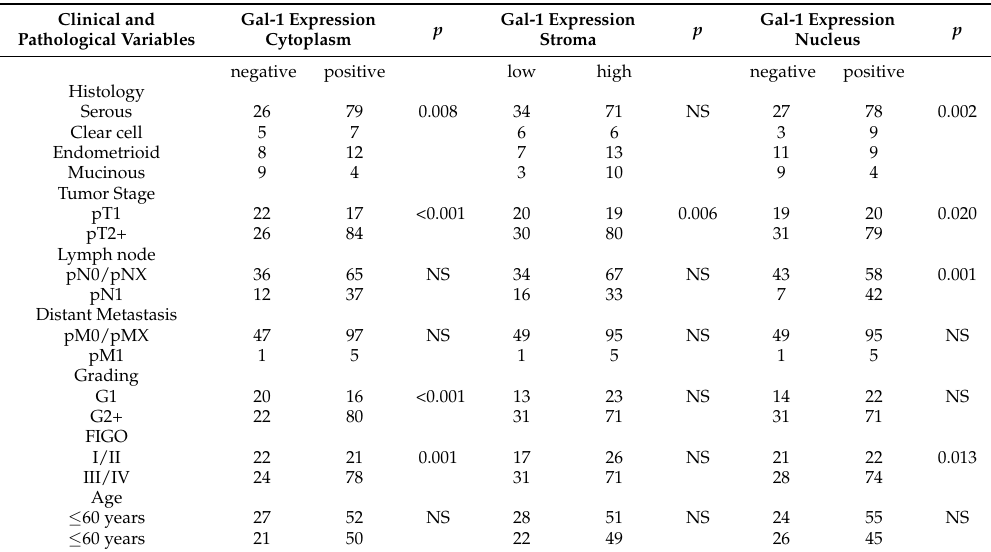
Figure 1. Detection of Galectins by immunohistochemistry. Representative photomicrographs are shown. Galectin (Gal)-1 was present in the cytoplasm and the nuclei of ovarian cancer cells ( A ) as well as the peritumoral stroma ( B ); Gal-3 staining was observed in the nuclei, cytoplasm ( C ), and stroma ( D ); Staining for Galectin-7 was mainly observed in the cytoplasm ( E ); only a few individual cases showed nuclear staining ( F ); 10× magnification was used for the outer pictures and 50× magnification for the inserts. The scale bars in in the outer pictures equal 200 μ m (10× magnification) and the scale bars in the inserts equal 100 μ m (50× magnification). Table 1. Gal-1 staining correlated with clinical and pathological data.